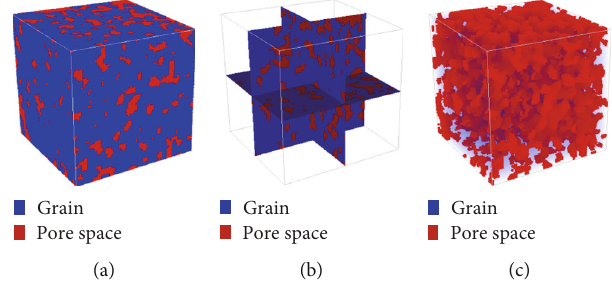
Figure 6: A reconstructed image using IVAE: (a) exterior; (b) cross-sections ( X = 32 , Y = 32 , and Z = 32 ); (c) pore space.